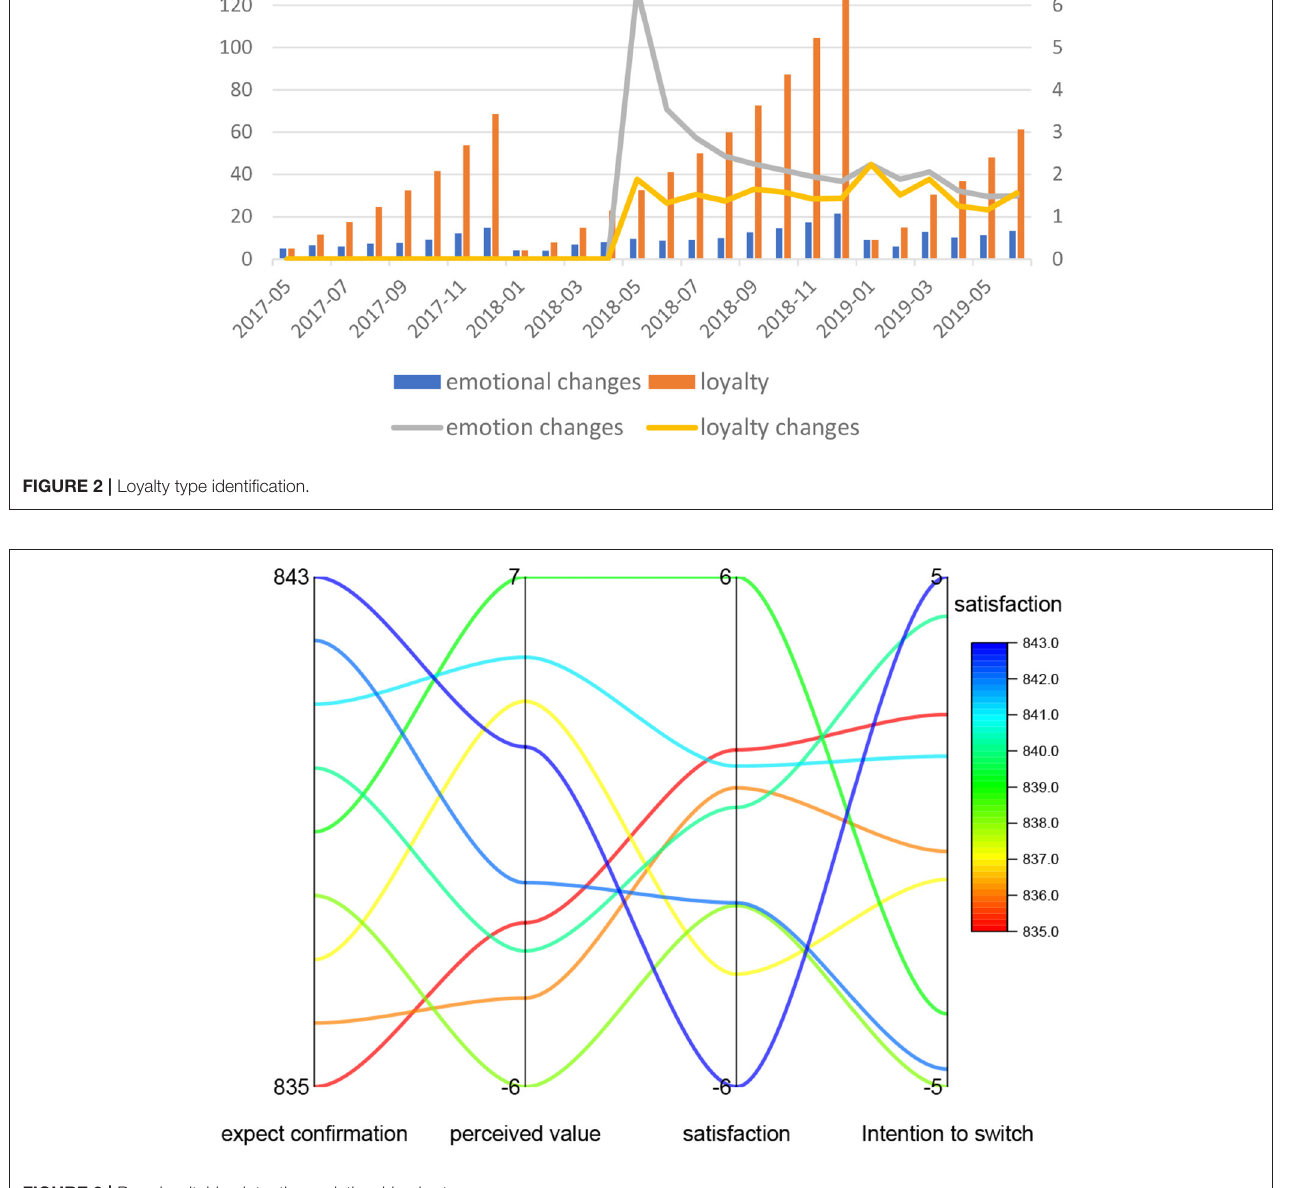
FIGURE 3 | Brand switching intentions relationship